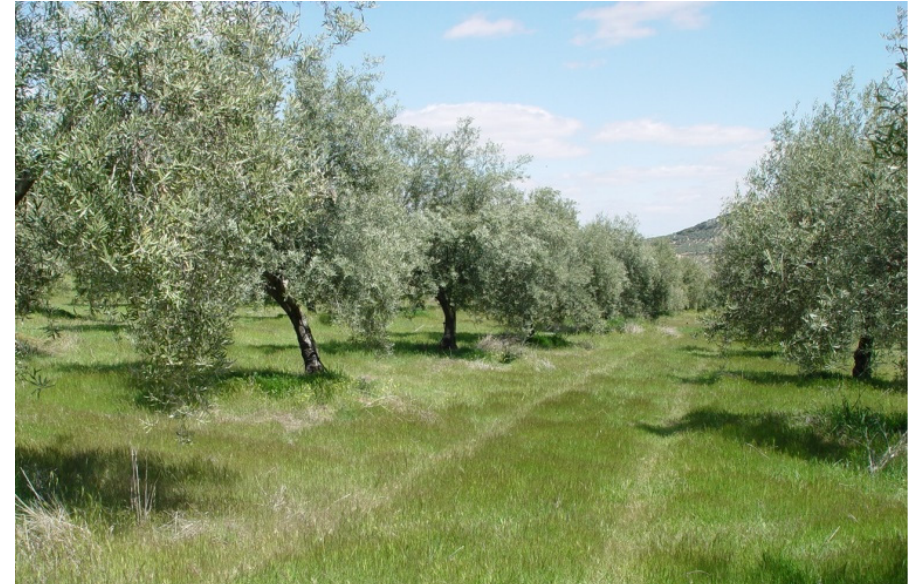
Figure 8. Sustainable agriculture, olive cultivation with leguminous and Poaceae species.